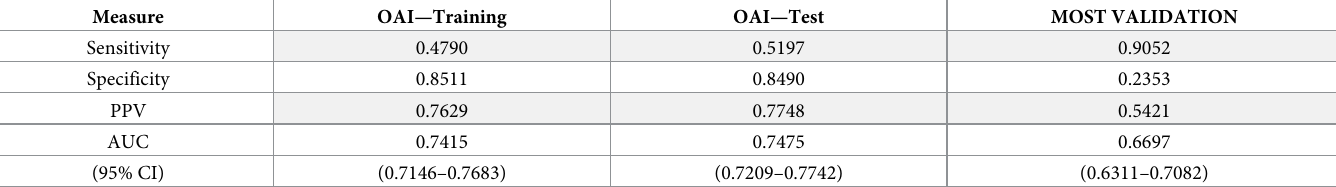
Table 4. Summary statistics for the diagnostic model.